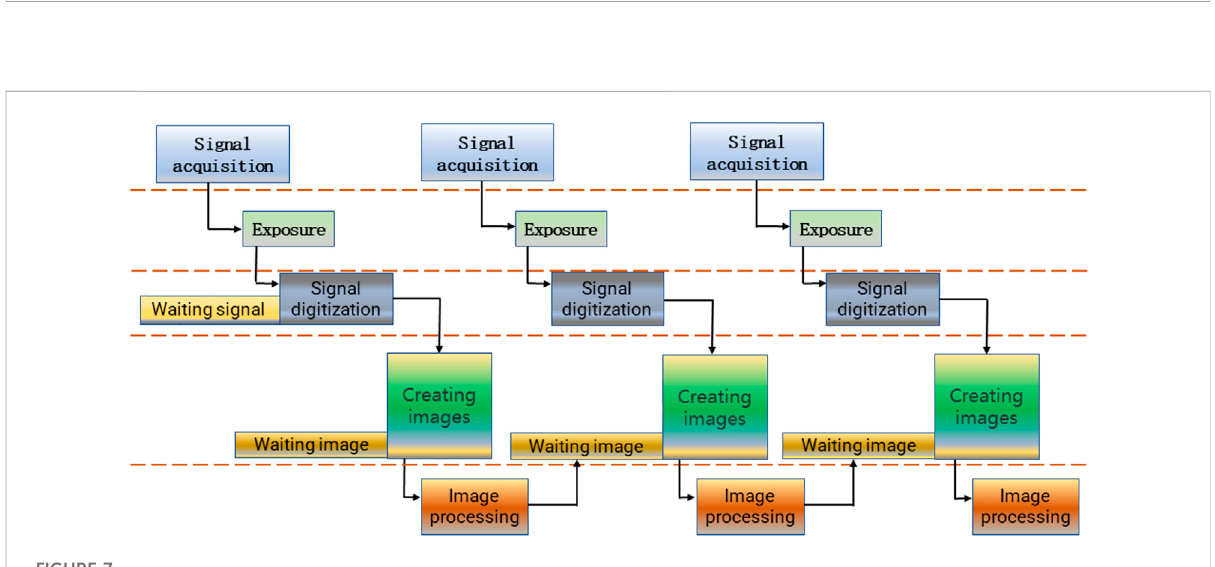
FIGURE 7 Flow chart of asynchronous